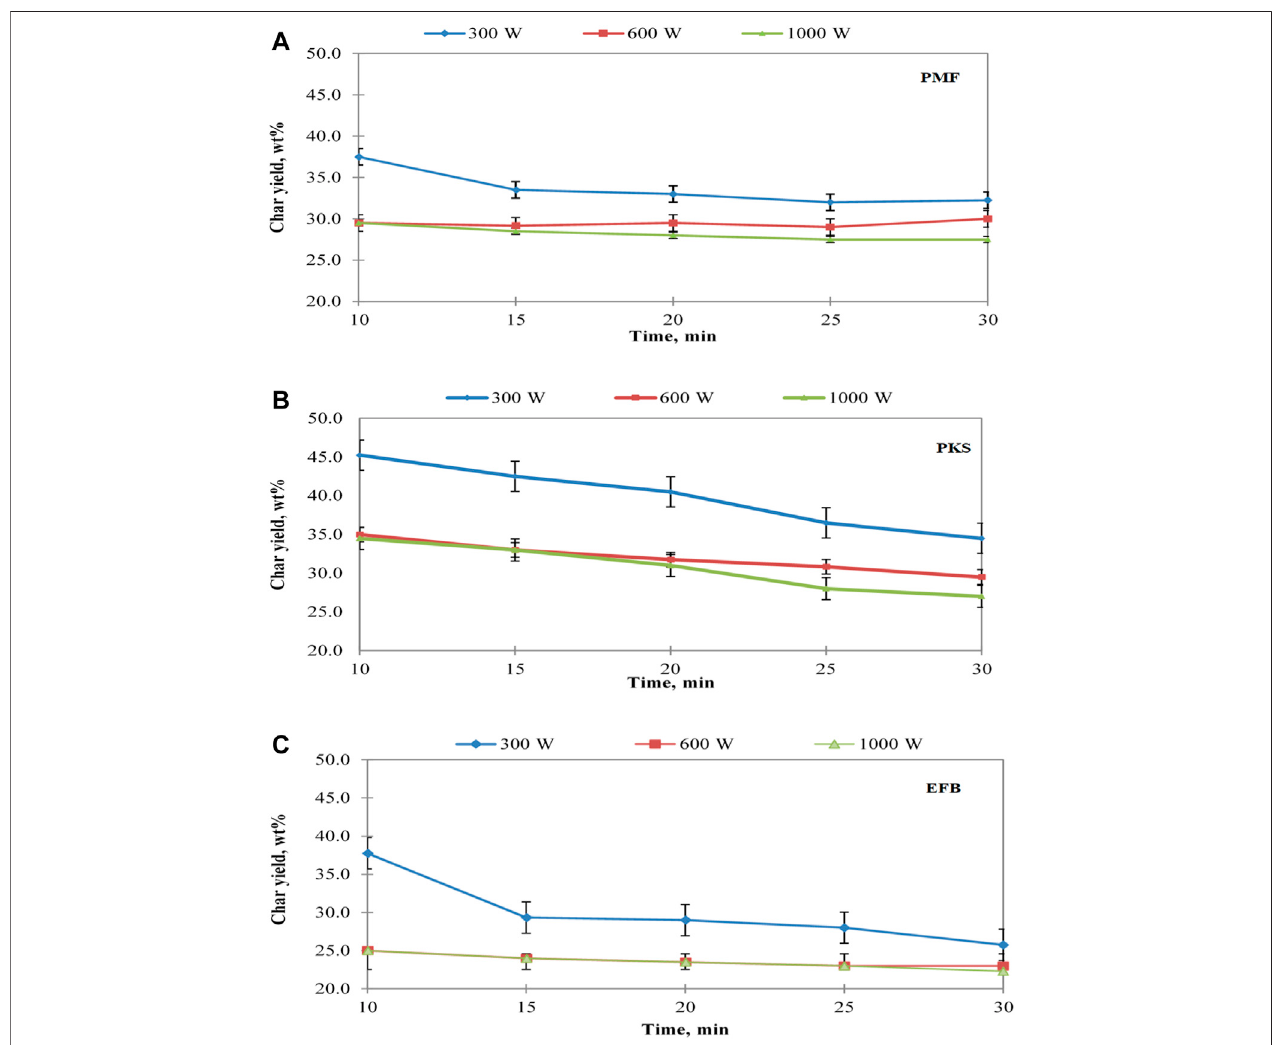
FIGURE 5 | Effect of exposure time on char yield for (A) PMF (B) PKS, and (C) EFB at different power level.